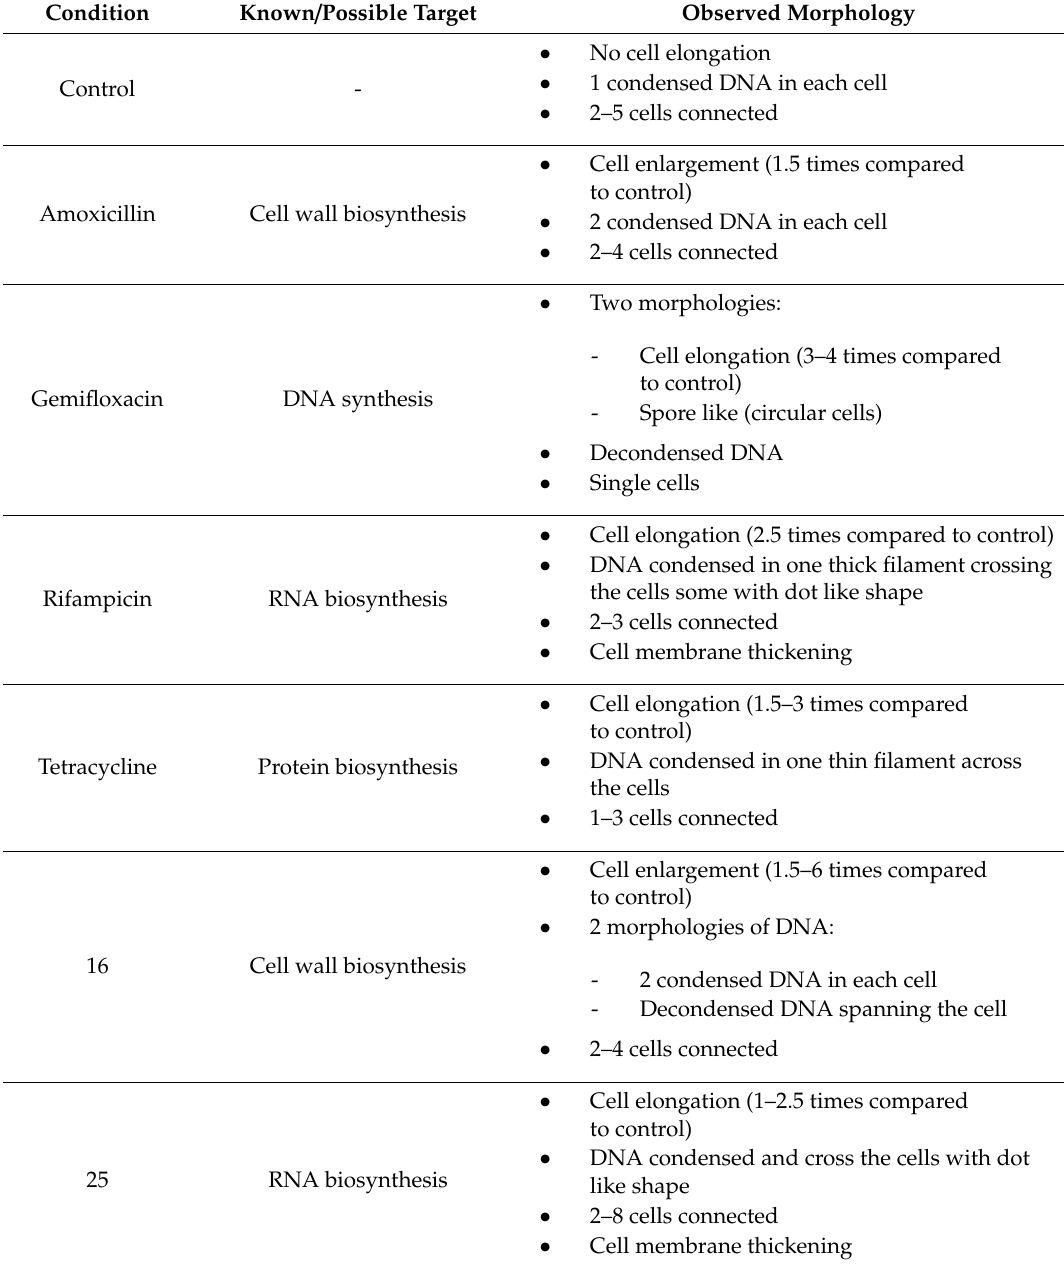
Table 5. Description of the morphological changes caused by conventional antibiotics or berberine’s derivative 16 and 25 in B. subtilis . Morphological changes of B. subtilis caused by conventional antibiotics and compounds 16 or 25 illustrated in Figures 7–9 are summarized in this